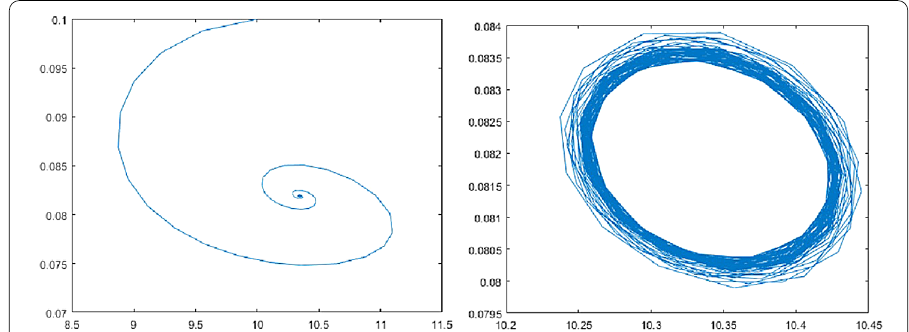
Figure 1 Left: r 1 = 0.200, the positive equilibriums p ( u 0 , v 0 ) is locally asymptotically stable. Right: r 1 = 0.029, p (